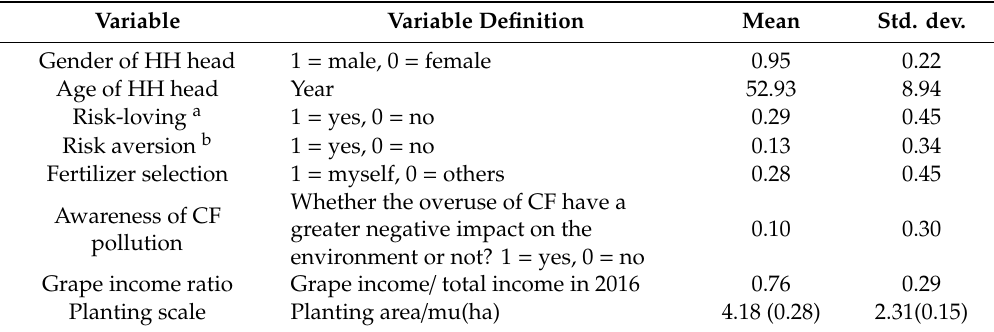
Table 2. Descriptive statistics of the characteristics of the sample